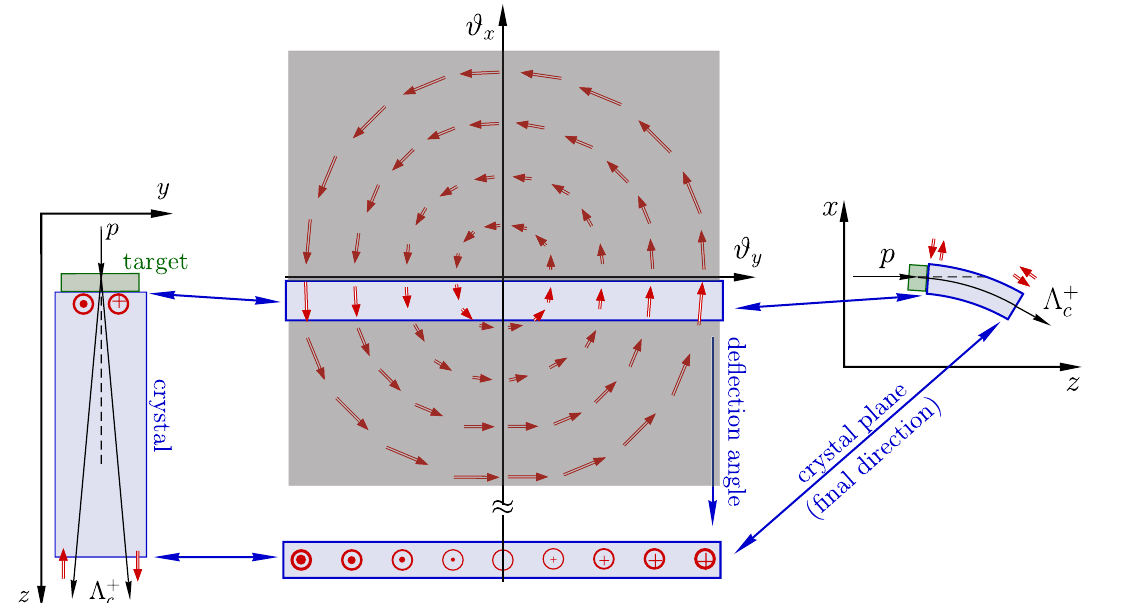
Fig. 2 Selection of Λ c initial polarisation by the crystal, and spin pre- cessioninabentcrystal(forthecase φ = π/ 2).(Middle)thedistribution of the Λ c polarisation in the phase space ϑ x ϑ y , here ϑ = is the angle between the proton and the Λ c momenta. Red arrows show the Λ c polarisation. The distribution is symmetric with respect